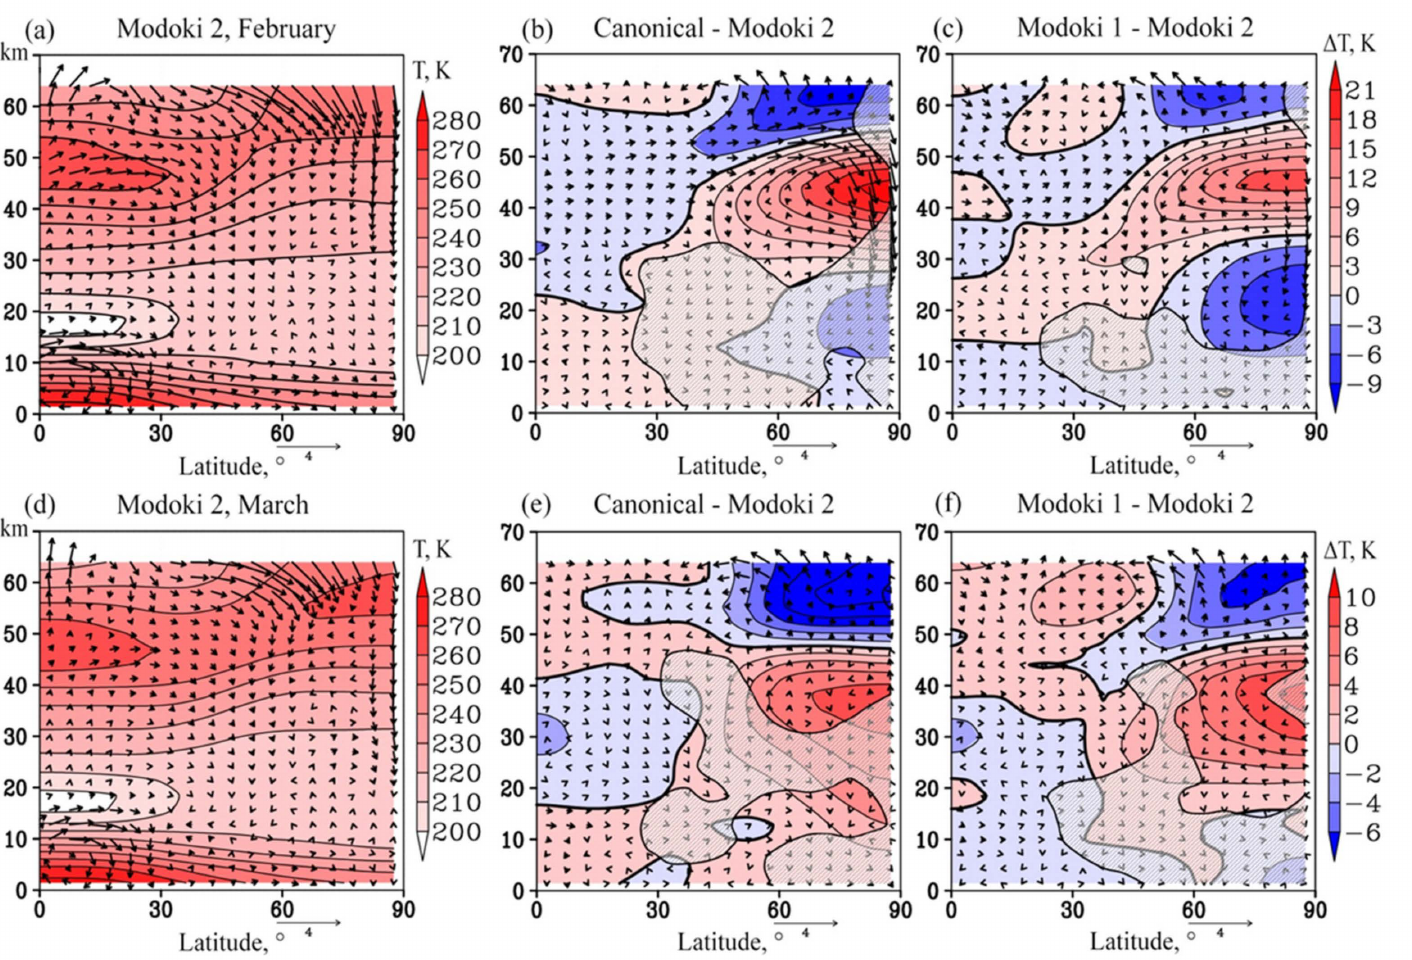
Figure 3. Monthly averaged residual mean meridional circulation (arrows, m/s, vertical component is multiplied by 200) in February ( upper panels ) and March ( bottom panels ) during Modoki II El Niño event ( left panels ); difference between Canonical and Modoki II ( middle panels ); difference between Modoki I and Modoki II ( right panels ). Color shading shows zonal-mean temperature (K). Hatched areas show insignificant temperature and/or RMC increments (at